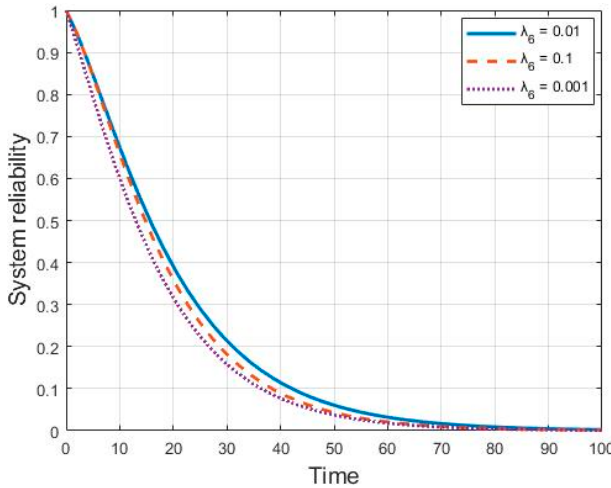
Figure 6. System reliability comparison with the changes of failure rate λ 6 .